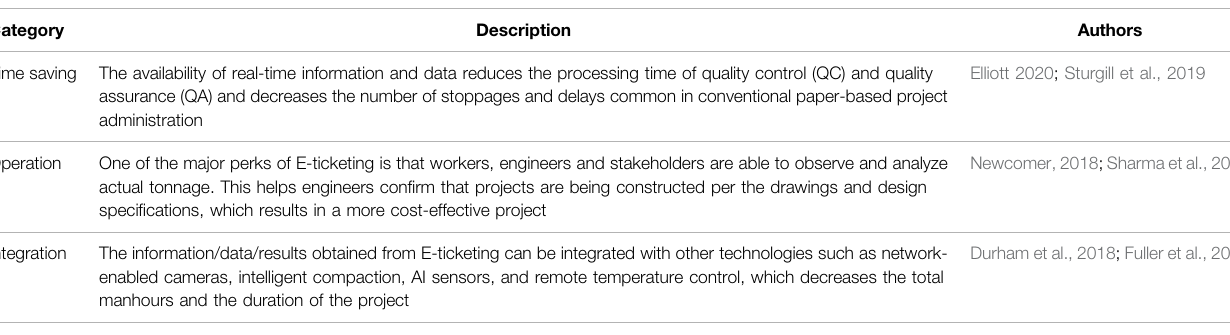
TABLE 3 | Cost and duration bene fi ts of E-ticketing.